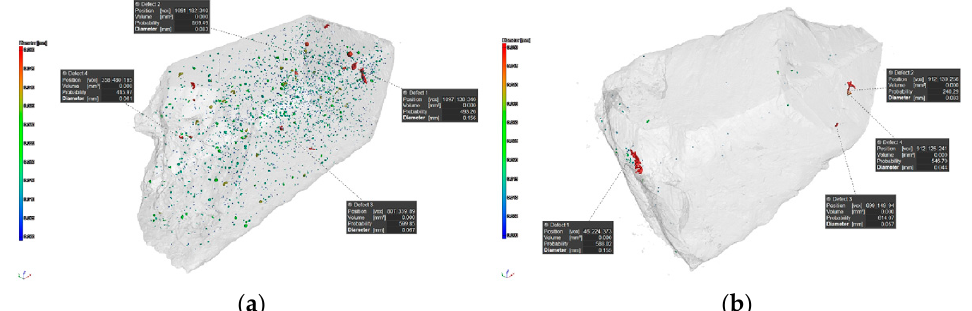
Figure 34. CT results of AlSi 10 Mg samples: ( a ) deposited state and ( b ) HIPed state [37].